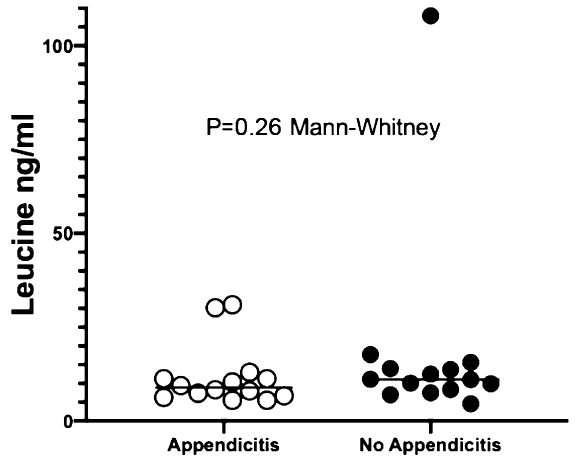
Figure 1. Plasma levels of leucine (LRG1) in patients with and without